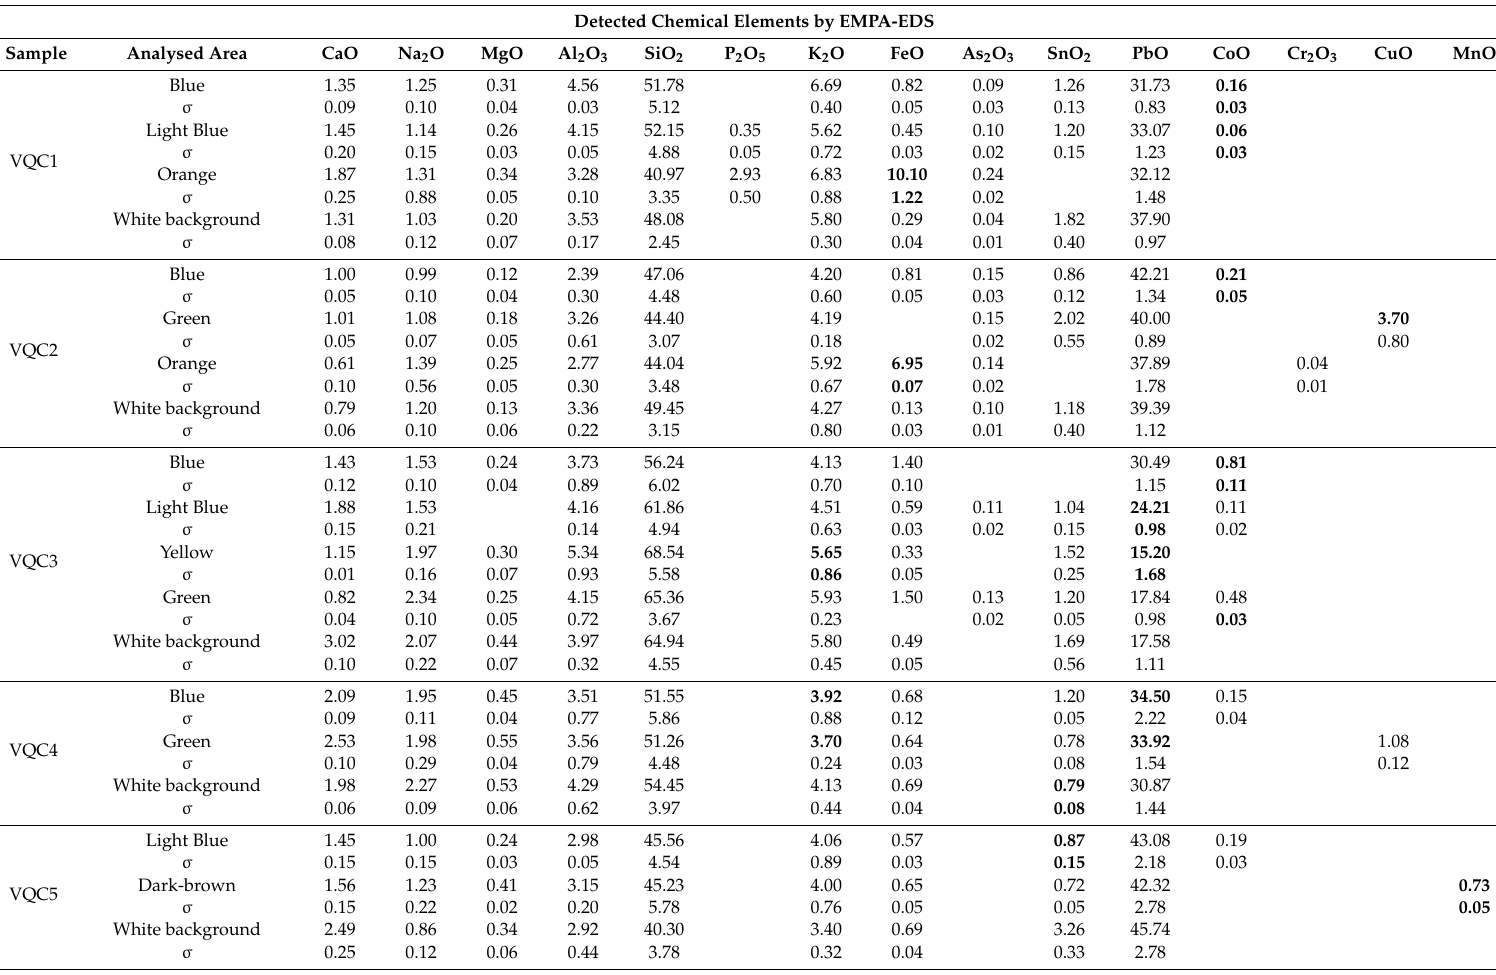
Table 4. EMPA-EDS chemical data (wt%) of the examined samples and related standard deviation. The main key elements responsible for coloured areas are marked in